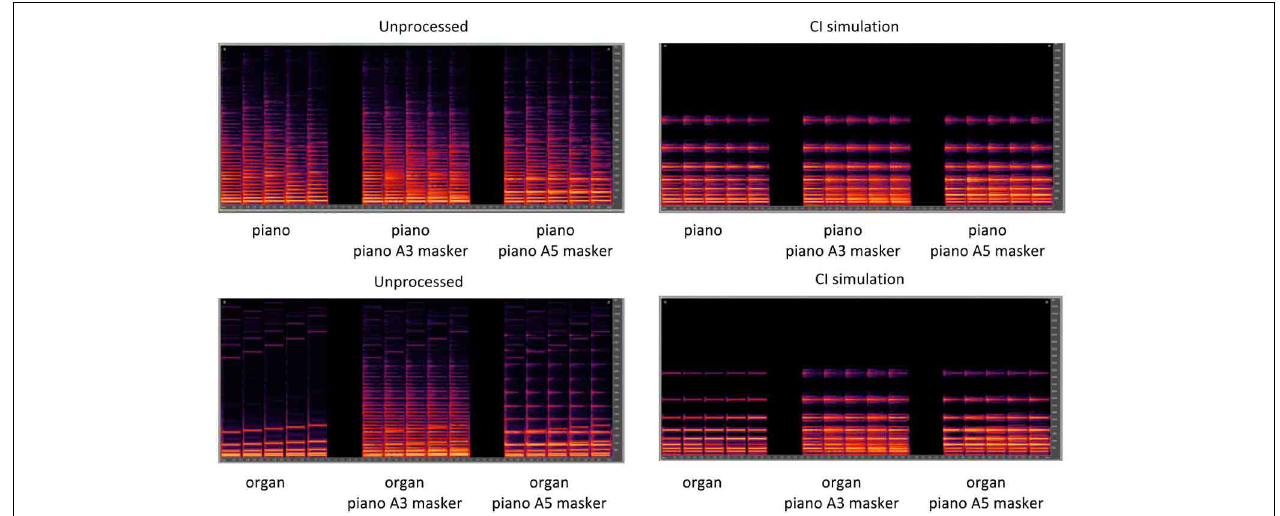
FIGURE 8 | Spectrograms for a Rising target melodic contour with 1-semitone spacing. The top panels show the piano target with the piano A3 and A5 maskers and the bottom panels show the organ